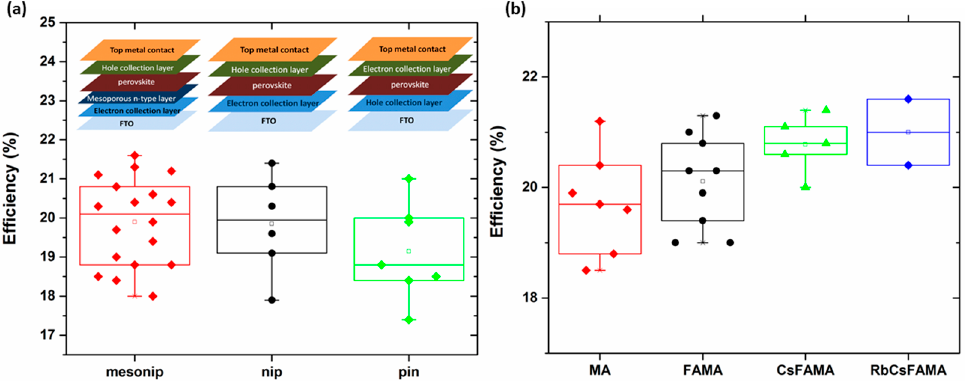
Figure 7. Overall photovoltaic efficiencies of perovskite solar cells with various mixed (or not) perovskite films fabricated via a combined intermediate/anti-solvent crystallization method: ( a ) mesonip, nip and pin cells refer to a specific architecture depicted in the figure as an inset. See text for further details. ( b ) MA, FAMA, CsFAMA and RbCsFAMA refer to compounds consisting of pure MAPbI 3 , mixed FAPbI 3 -MAPbI 3 , Cs + -doped mixed FAPbI 3 -MAPbI 3 and Rb + /Cs + -co-doped mixed FAPbI 3 -MAPbI 3 , respectively. Note that various types (meso n-i-p, n-i-p and p-i-n) of highly efficient (over 18.5%) solar cells are included in the statistical analysis. Data were taken from the references existing in the present manuscript.